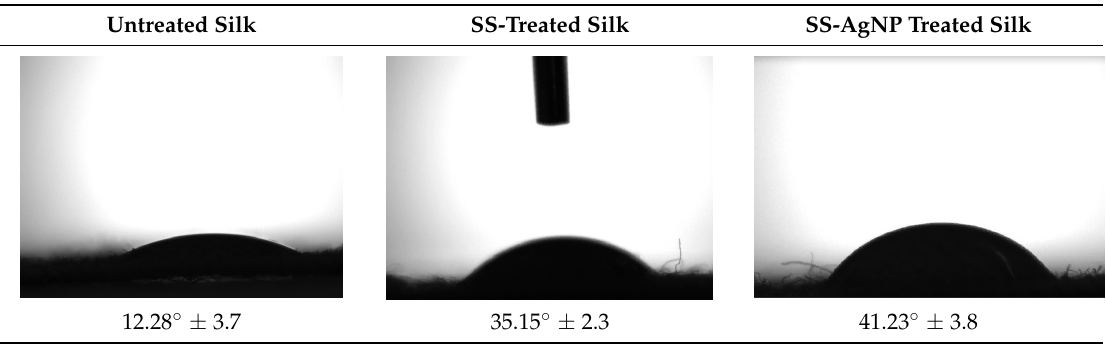
Table 5. The water contact angles of untreated and treated silk fabrics.